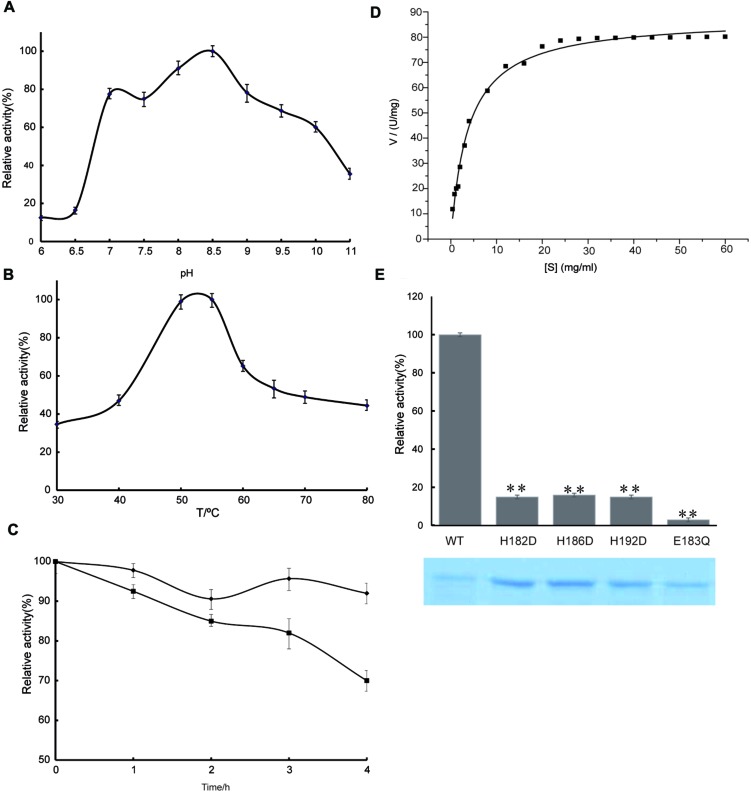
Enzyme activity assay of AMZ-tk. (A) Optimal pH of AMZ-tk. Different buffers were used for the different pH solutions in this assay. MES buffer was used for pH 5.0–7.5; HEPES buffer was used for pH 8 and 8.5; glycine buffer was used for pH 9.0 and 10.0; and Na2HPO4 buffer was used for pH 11.0. Values obtained at pH 8.5 were set as 100%. (B) Optimal temperature of AMZ-tk. Values obtained at 55°C were set as 100%. (C) After inactivation of AMZ-tk at 70°C (filled diamonds) and at 80°C (filled squares) for 1–4 h, the activity of the enzyme was assayed at 55°C as described in Section “Materials and Methods.” (D) Effects of substrate concentration on the velocity of the AMZ-tk. Assays were performed as described in Section “Materials and Methods.” (E) Relative activity of wild-type AMZ-tk, H182D, H186D, H192D and E183Q with casein as substrate. The lower part shows the corresponding proteins determined by SDS-PAGE. The parameters reported here are the means of three determinations. ∗∗p < 0.01 compared with wild-type AMZ-tk.